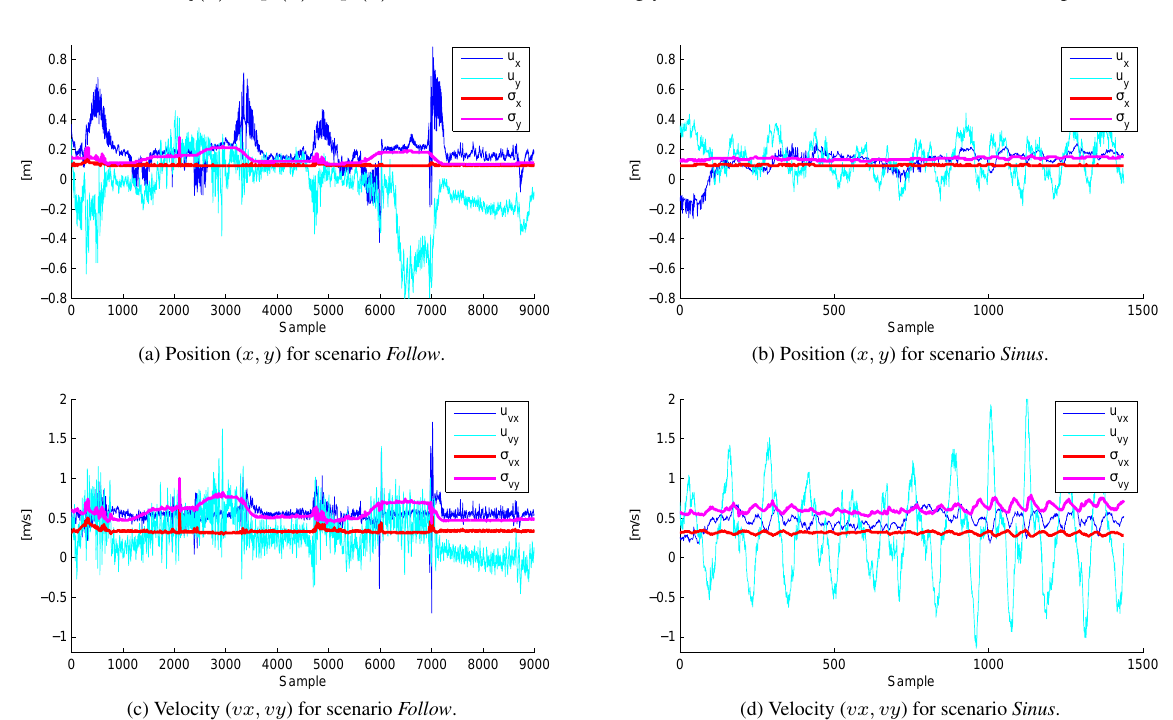
Figure 7: Uncertainties ( u q ) to reference and estimated standard deviations ( σ q ) of the scanner for position and velocity during the